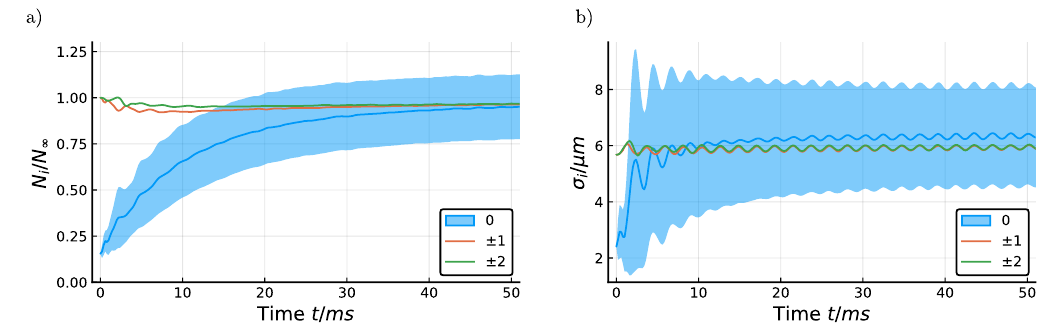
Figure 2: Dynamics of a) fillings and b) transversal widths of the central atomic = 8 E cloud and its two nearest-neighbors at V . The ribbons indicate the standard z r / 2 and ∆ σ / 2 of the central cloud. deviations ∆ N 0 0